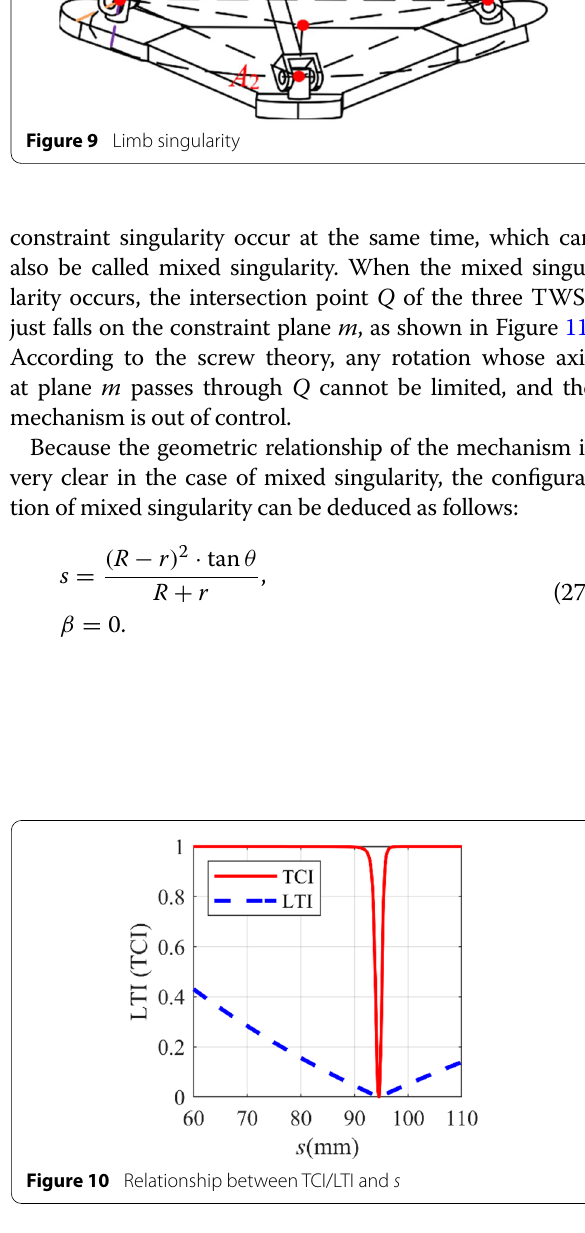
Figure 8 Constraint singularity